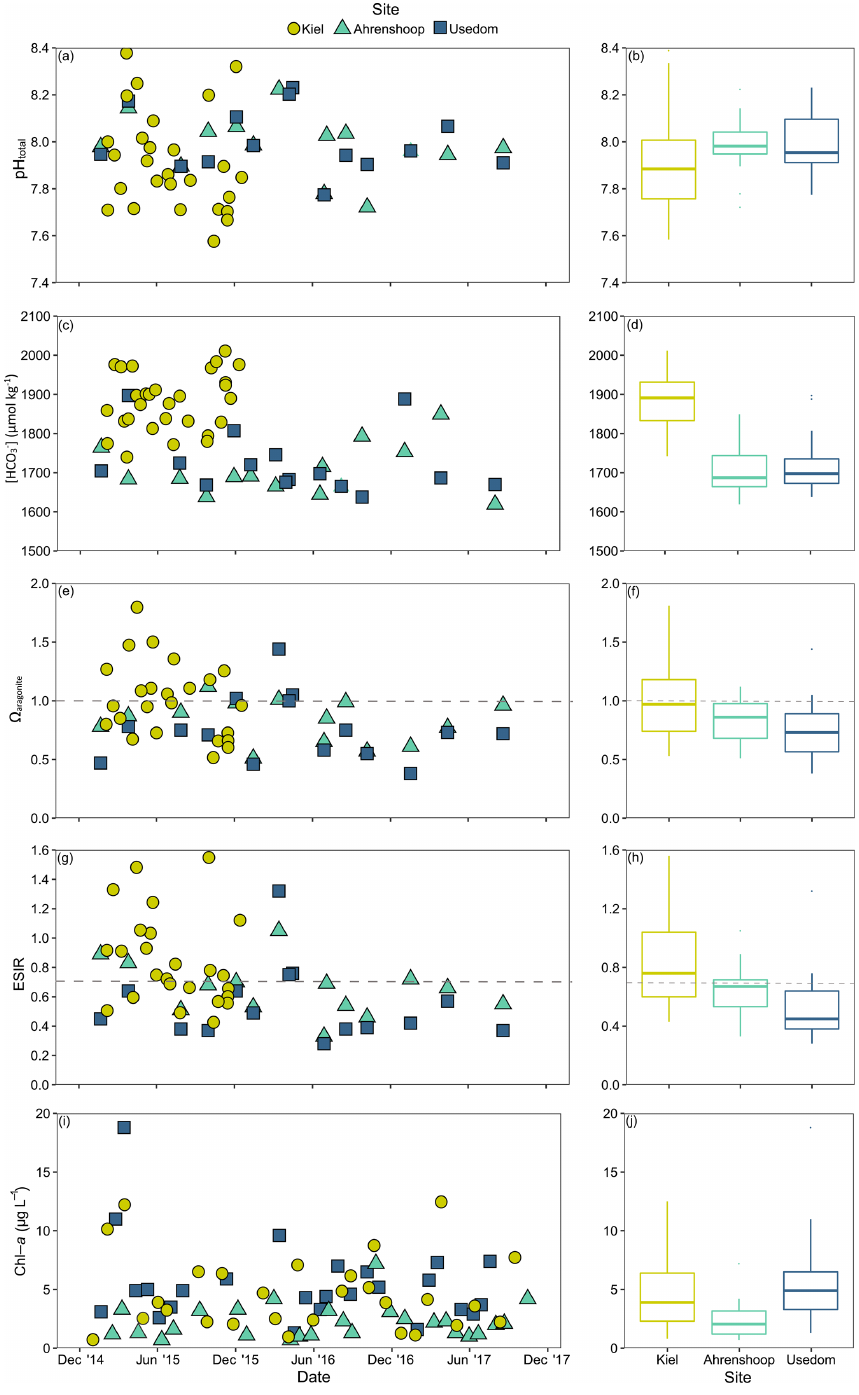
Figure 3. Environmental monitoring data from Kiel, Ahrenshoop and Usedom. Time series for pH total ( − log 10 [ H + ] ) at in situ tempera- tures (a) and associated boxplots (b) ; [HCO − ] (c) , and boxplots (d) ; (cid:127) aragonite with the horizontal dashed line depicting the theoretical 3 saturation threshold of (cid:127) aragonite = 1 (e) , and boxplots (f) ; extended substrate–inhibitor ratio ([Ca 2 + ][HCO − ] / [H + ]) with the horizontal 3 dashed line depicting the theoretical saturation threshold of ESIR = 0.7 (g) and boxplots (h) ; chl- a as a proxy for food availability (i) and boxplots (j) . Details describing carbonate chemistry calculations are described in Sect. 2.1. Boxplots display median values and interquartile ranges excluding